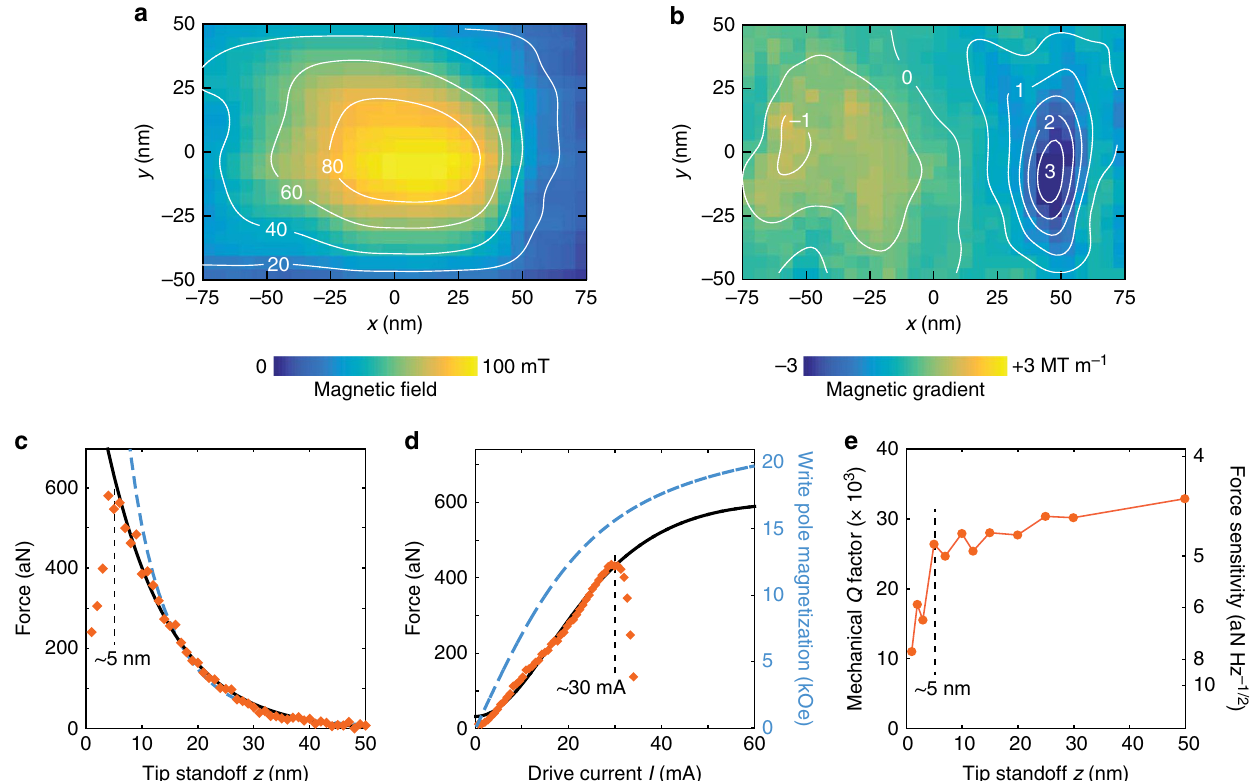
Figure 5 | Quantitative field maps and estimated limits. ( a , b ) Two-dimensional images of the magnetic field ( a ) and field gradient ( b ) for 5mA drive and 30nm standoff. Contour labels are mT and MTm (cid:2) 1 , respectively. ( c ) Force signal as a function of tip standoff z , measured at the xy location with the highest signal. The solid line is an exponential fit with decay length d ¼ 11.3 ± 0.6nm. The dashed line is the prediction by the finite element model that was vertically scaled to fit the data. Drive was 12mA. ( d ) Cantilever signal as the drive was increased beyond the breakdown current of B 30mA. The solid line is a fit based on the magnetization curve of FeCo (Supplementary Information). The dashed line (right scale) is the associated pole magnetization. Tip standoff was 20nm. All data are from tip B. ( e ) Mechanical quality factor Q and force sensitivity F min of the transducer as a function of tip standoff z . A force sensitivity of B 5aNHz (cid:2) 1/2 is maintained down to z ¼ 5nm. Table 1 | Pole field and gradient extracted from study.